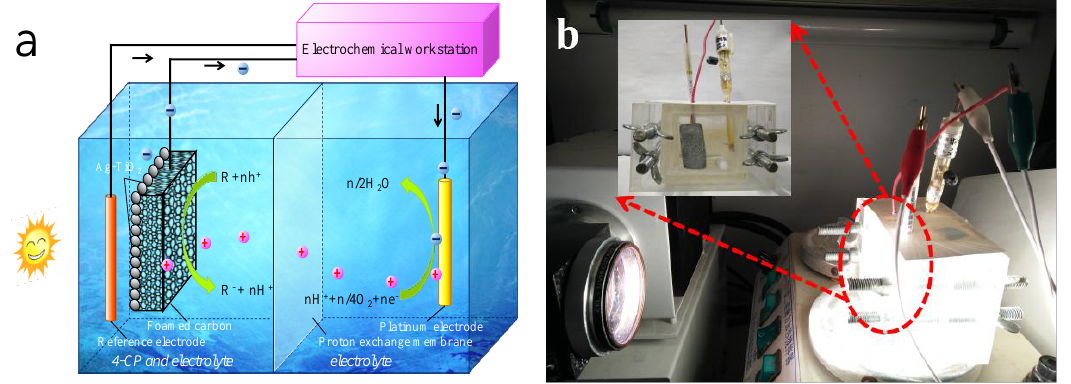
Figure 1. ( a ) Schematic diagram and ( b ) reactor set-up of the photocatalytic fuel cell (PFC).